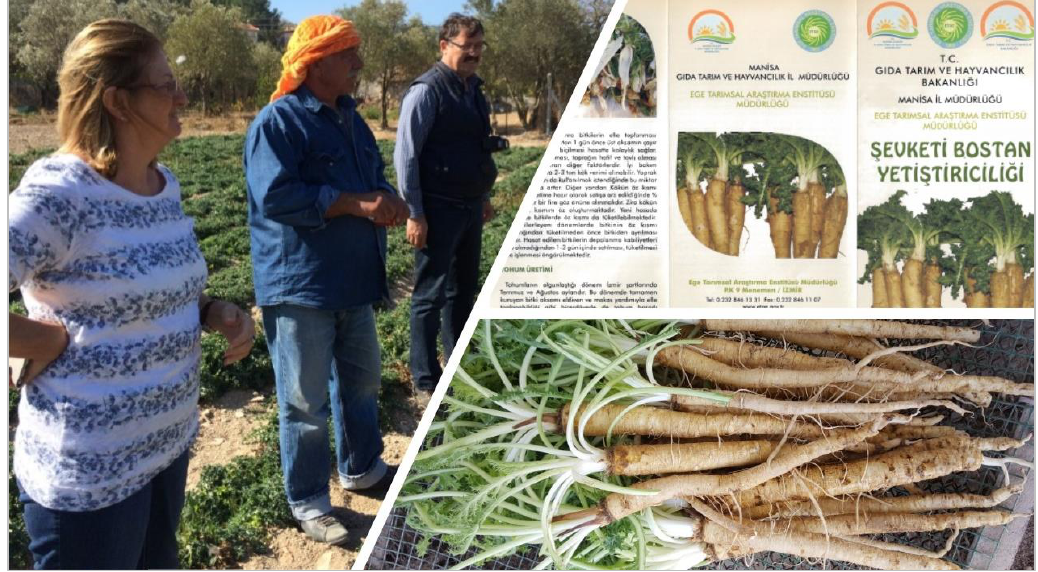
Figure 5. From left to right, top to bottom. BFN Turkey work with farmers to test domesticated golden thistle ( Scolymus hispanicus L.); the sustainable production guidelines; and harvested golden thistle roots ready for sale Credit: BFN Turkey.